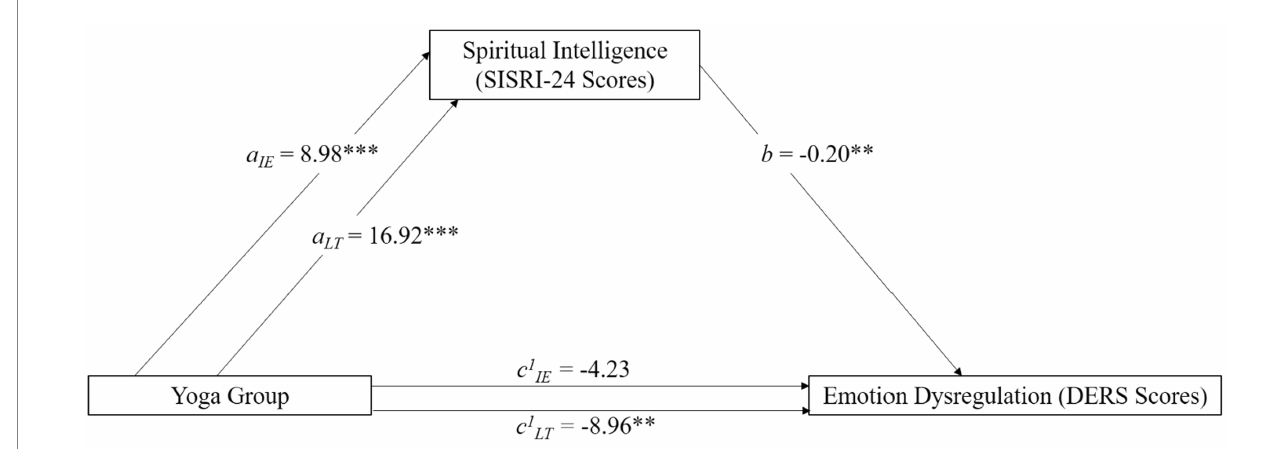
FIGURE 5 Mediation model featuring yoga practice (predictor), emotion dysregulation (outcome), and spiritual intelligence (mediator). Variables with subscript IE represent a comparison between the no experience and intermittent experience (IE) group. Subscript LT represents a comparison between the no experience and the long-term (LT) group. Significance is represented with ** ( p < 0.01) or *** ( p < 0.001). No asterisk represents a non-significant finding.